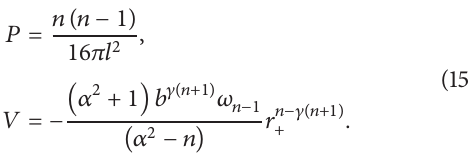
where 𝜆 = (𝑛−3)(1−𝛾)+1 , and the pressure and volume are,